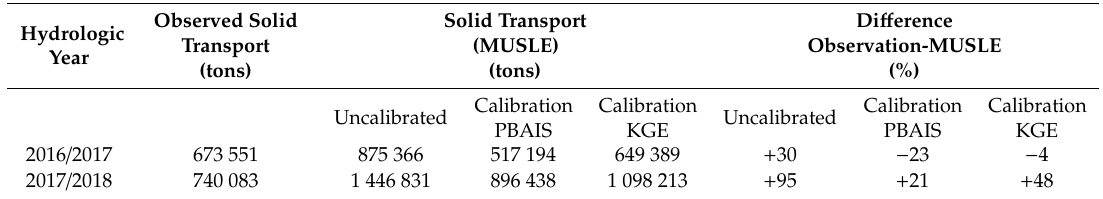
Table 15. Results of the MUSLE model at Ras Fathia on the Grou and comparison with observations.